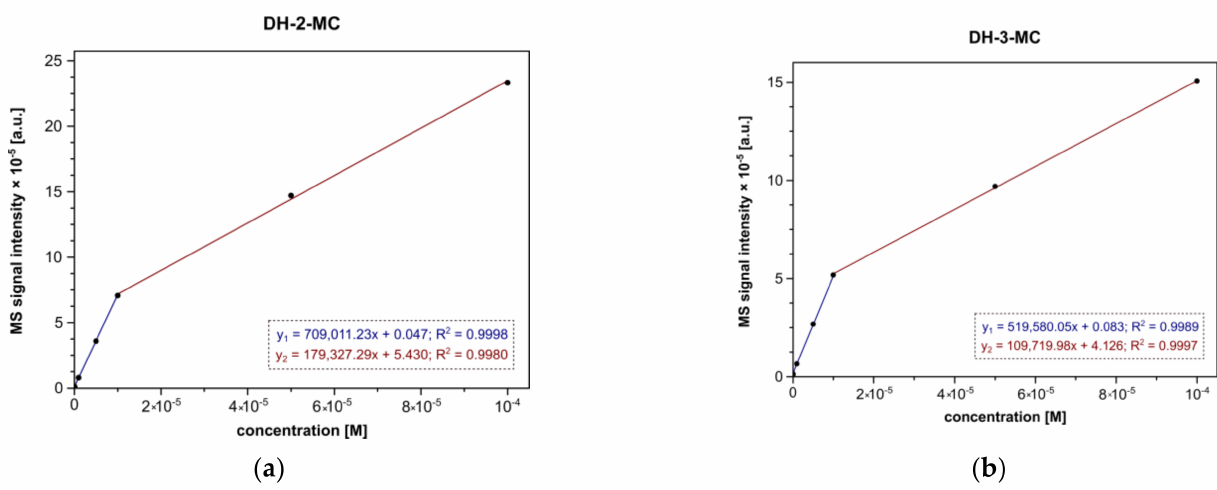
Figure 4. The ESI-MS calibration curves obtained for both chalcone analytes: ( a ) DH-2-MC and ( b )